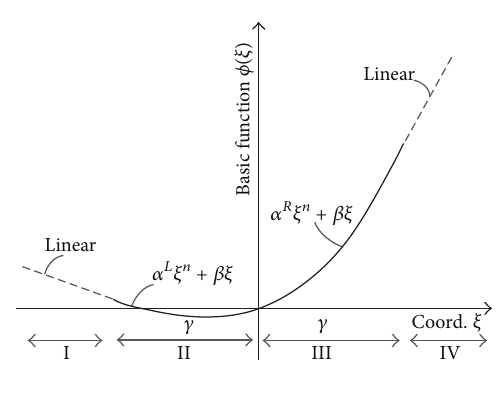
Figure 3: Nonradial basis